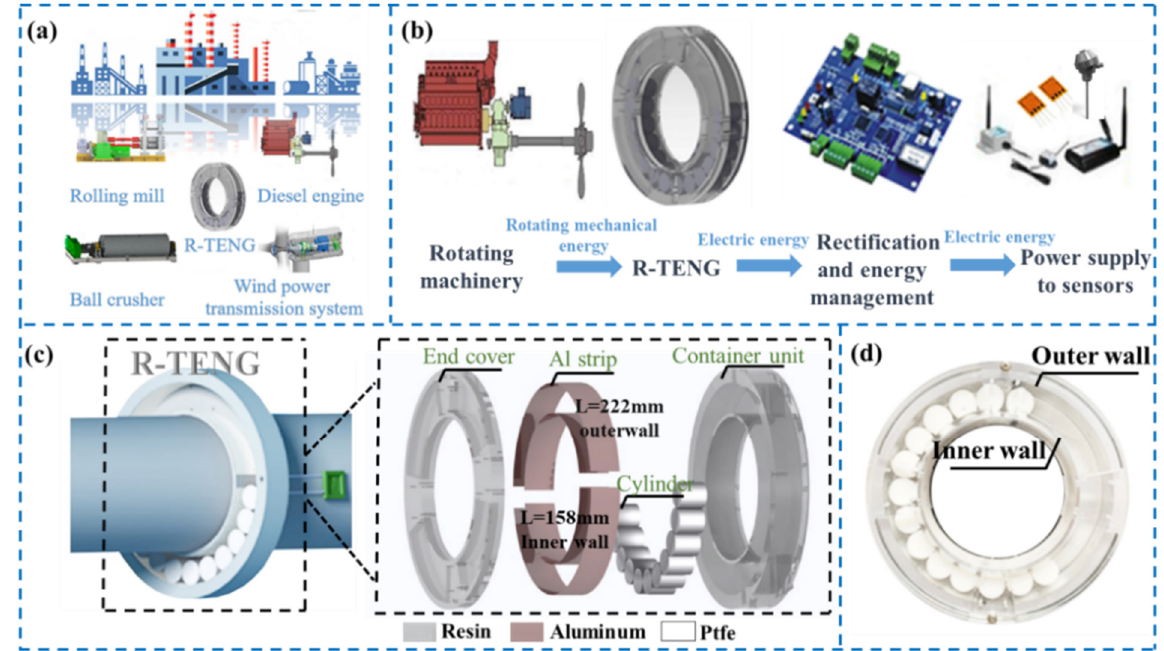
Figure 1. The structural design of the R-TENG: ( a ) potential application scenarios of the R-TENG in rotational mechanical energy harvesting; ( b ) schematic illustration of the rotational mechanical energy harvesting and power management system; ( c ) schematic illustration of the R-TENG mounted on a rotating shaft as a self-powered thermometer and the components of the designed R-TENG; ( d ) photograph of an assembled R-TENG.